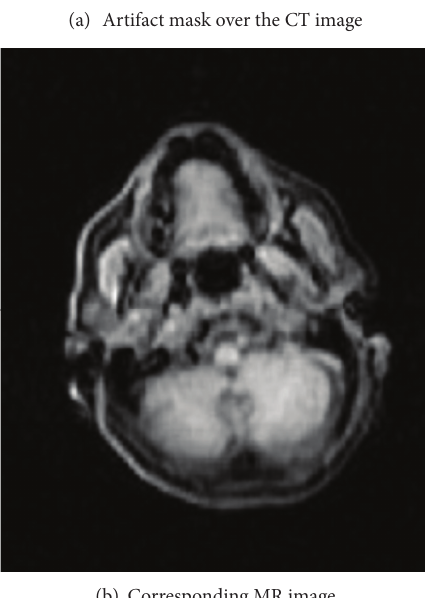
Figure 4: Axial view of CT dataset before (a) and after